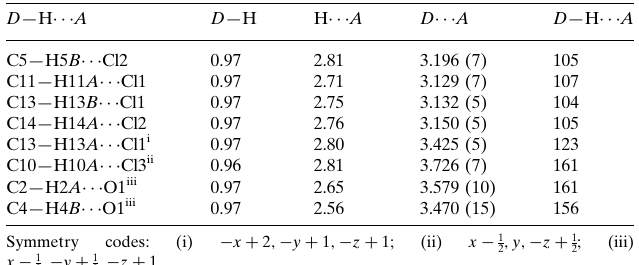
Hydrogen-bond geometry (A˚ , (cid:4)